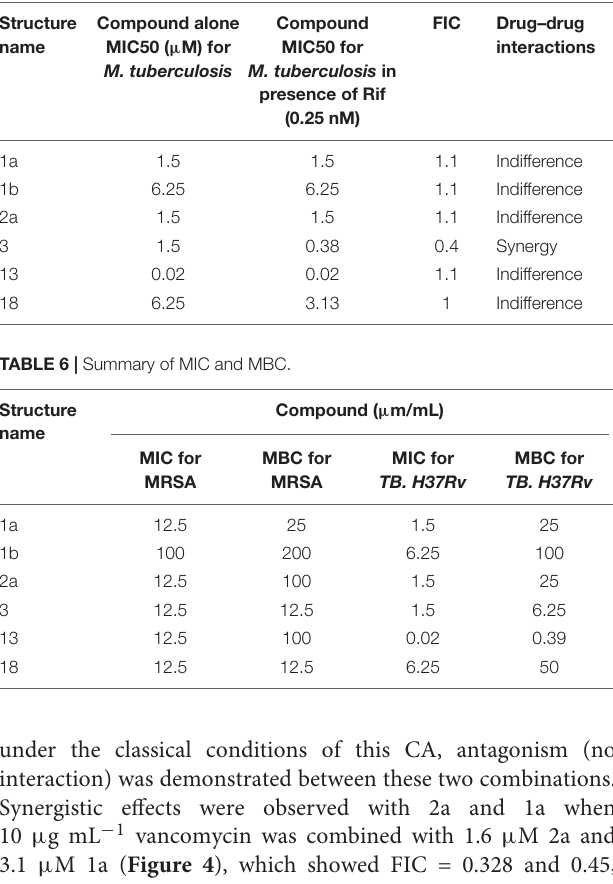
TABLE 5 | Summary of the checkerboard study between rifampicin and synthetic compounds.